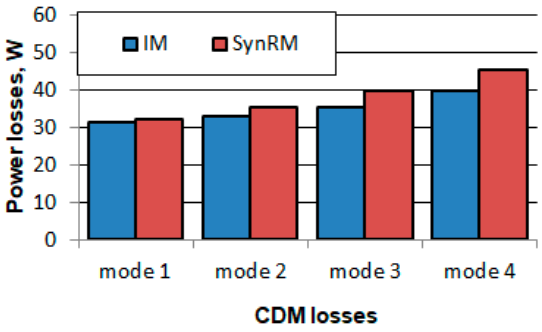
Figure 14. CDM losses for different types of motor in various modes.